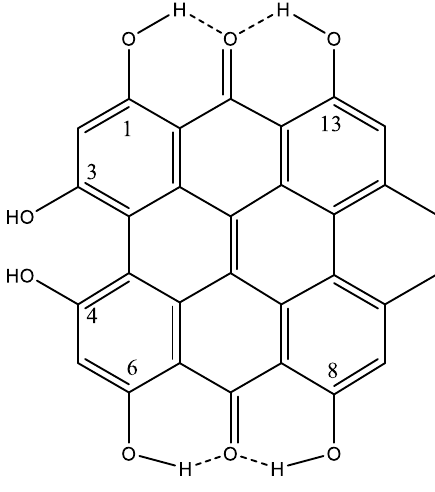
Figure 27. Hypericin. Figure 27.